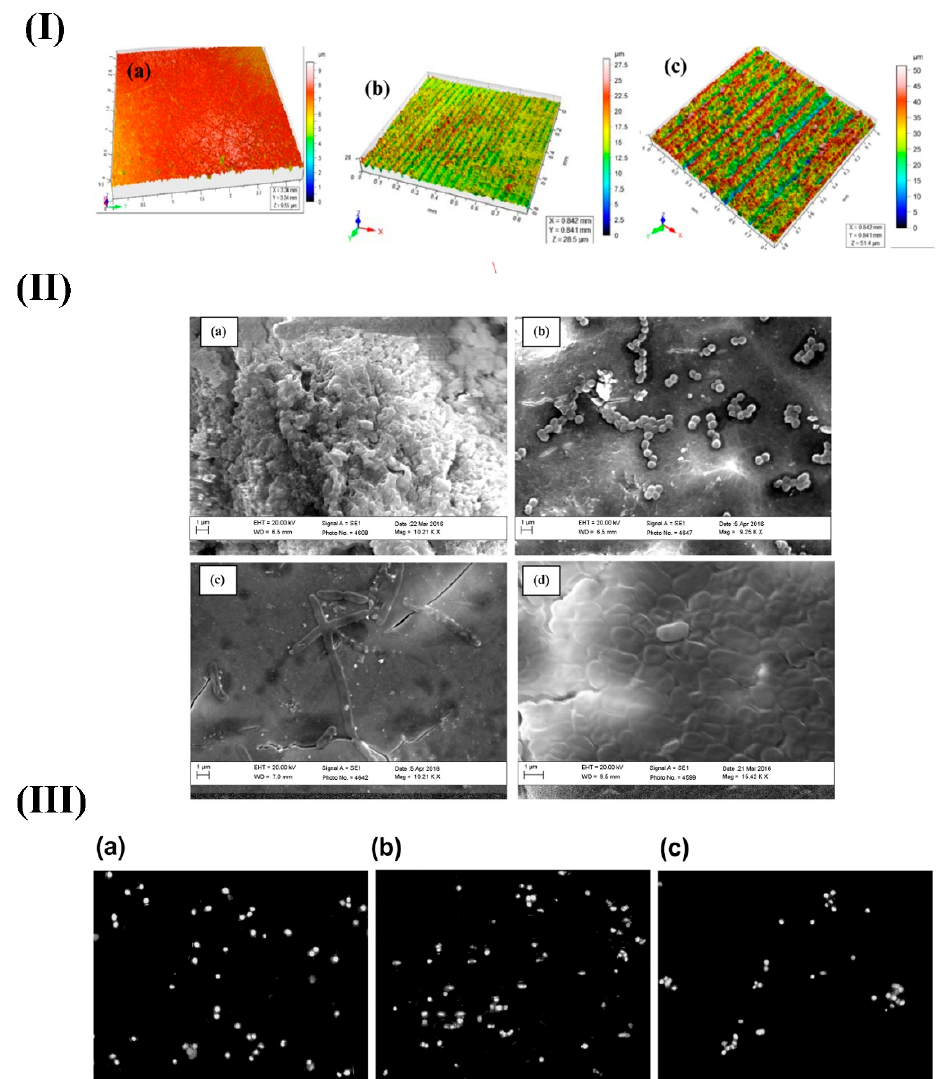
Figure 7. The biological outcomes of surface treatment of BGs by using the laser. ( I ) optical profilometer image of untreated BG ( a ) (sample1); laser-treated at fluence 1.0 J / cm 2 and sample scanning speed of 35 µ m / s ( b ) (sample2); and 15 µ m / s ( c ) (sample3). ( II ) SEM micrographs of sample 3 exhibiting no adherence of S. aureus ( a ); micrographs showing the attachment of S. aureus ( b ), P. aeruginosa ( c ), and ( d ) E. coli on the surface of untreated BGs. ( III ) The proliferation of INT407 cell line on untreated BGs, the sample3 and ( c ) Petri dish. Reproduced with permission from Reference [90] .